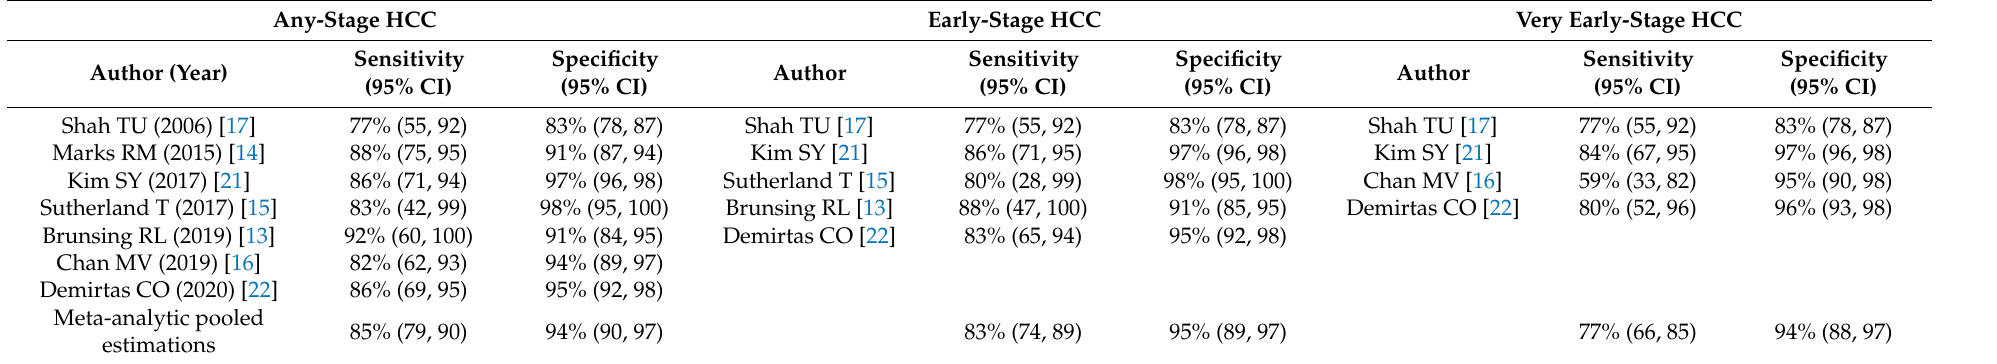
Table 2. Diagnostic performance of sMRI for any-stage HCC, early-stage HCC, and very early-stage